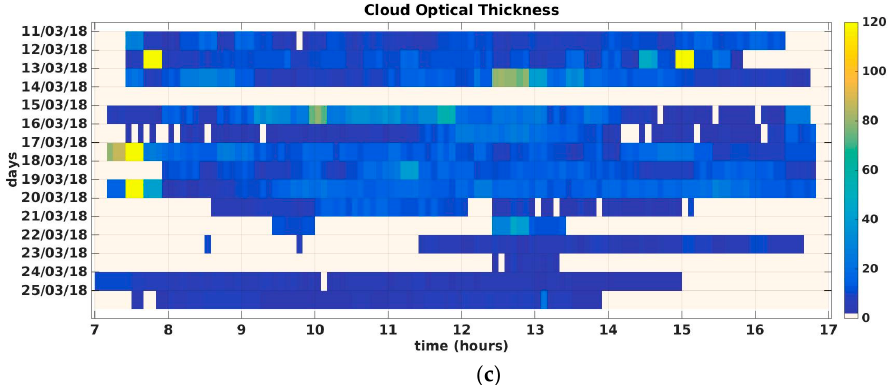
Figure 5. AMESIS-retrieved microphysical cloud parameters for the whole Ispra (Joint Research Centre (JRC)) site dataset, consisting of 12 (samplings) × 10 (hours) × 15 (days). ( a ) Cloud phase histogram. ( b ) Cloud top height. ( c ) Cloud optical thickness. Time is in UTC. Empty slots (white color) in ( b , c ) indicate the absence of clouds. Date format is dd/mm/yyyy. Tables 4 and 5 report the statistical scores related to the JRC site in Ispra, located in Northern Italy at an altitude of 220 m. The correlation coefficient and the RMSE of the high frequency-based irradiance estimates are generally better than the lower frequency ones. All the other statistical scores have very close values, except on 20 March 2018, in which case the MBE increases from − 7.56